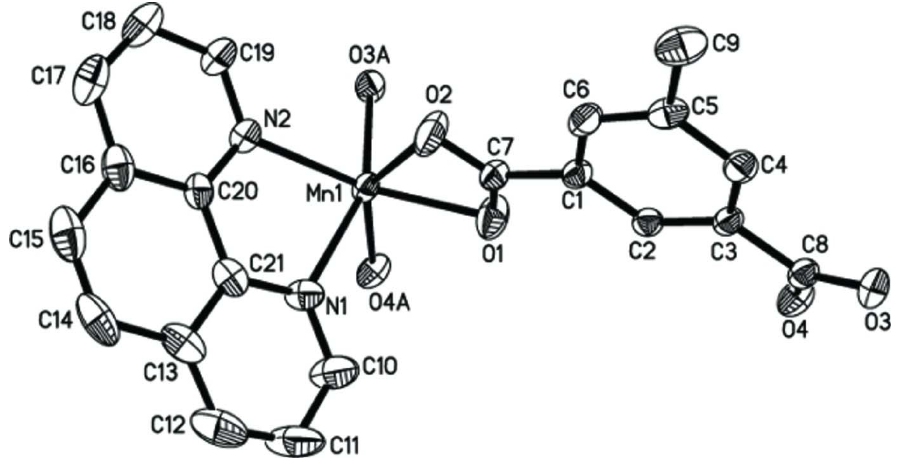
Figure 1 A portion of the title polymeric compound showing the atomic numbering and 40% probability displacement ellipsoids [symmetry code: (A) x,-y+1,z-1/2].